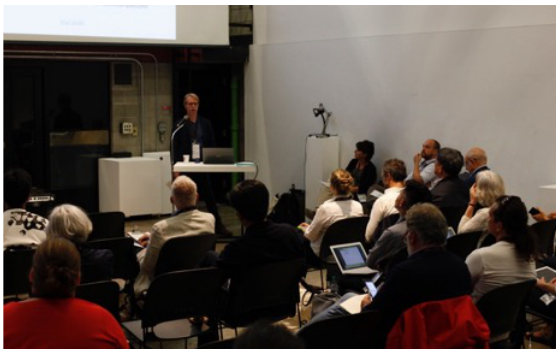
Figure 5: Arches workshop during the 26th CIPA International Symposium on Heritage Documentation, Ottawa, Canada,